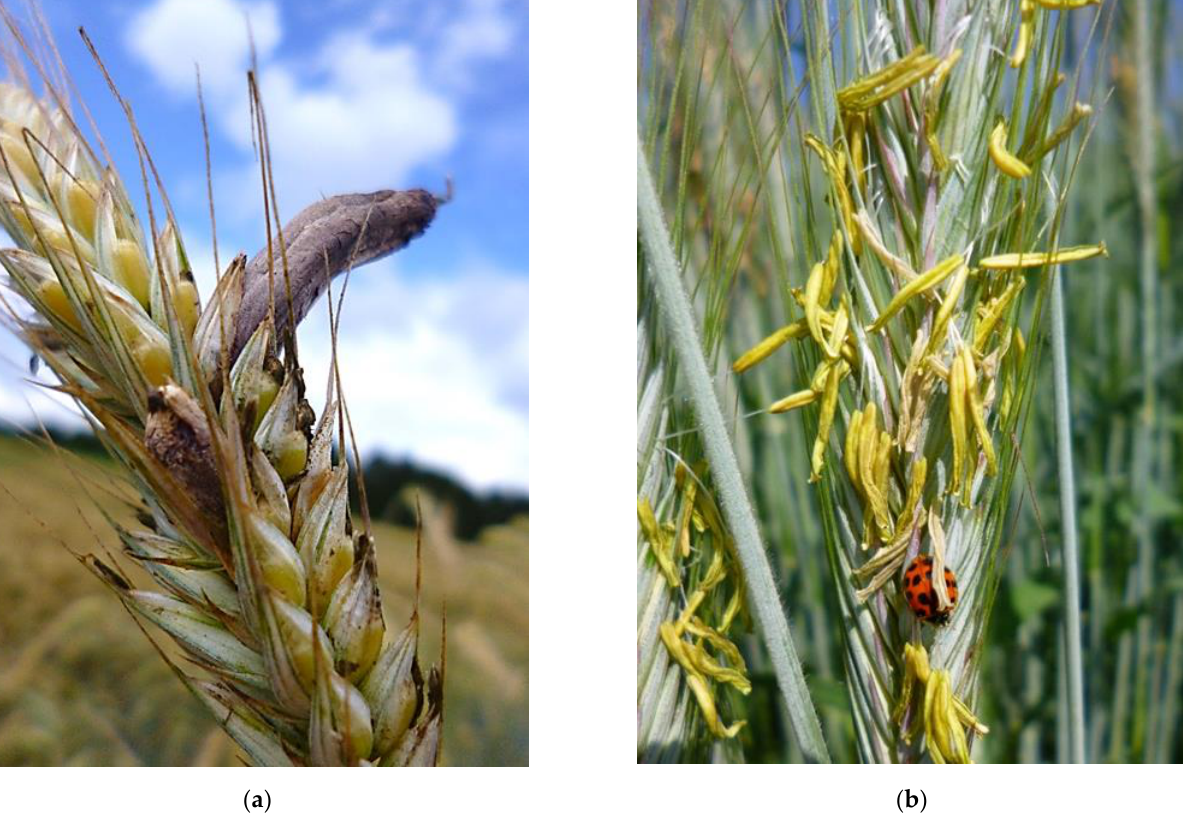
Figure 1. ( a ) Ergot sclerotia in a ripening rye head; ( b ) Full pollen-fertile rye during flowering. In rye, population varieties consist of self-incompatible plants, whereas hybrid vari- eties descend from self-fertile parental lines. The different types of varieties have conse- quences for the possible origin of pollen that is successful in pollinating. Whereas pollen in the first type of variety must bridge the physical distance from one plant to the other, in hy- brids that are autogamous (i.e., pollen from the same flower) or geitonogamous (i.e.,